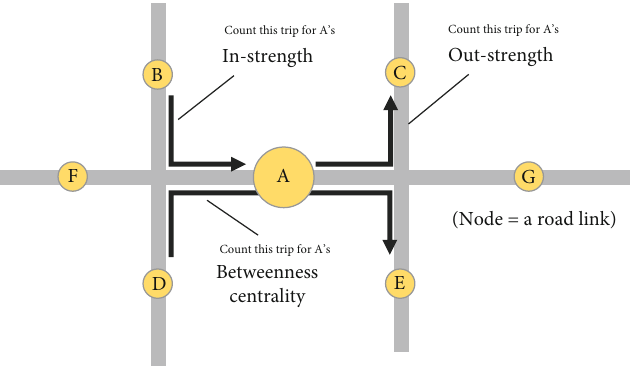
Figure 2: Concepts of a node, in-strength, out-strength, and betweenness centrality in a road